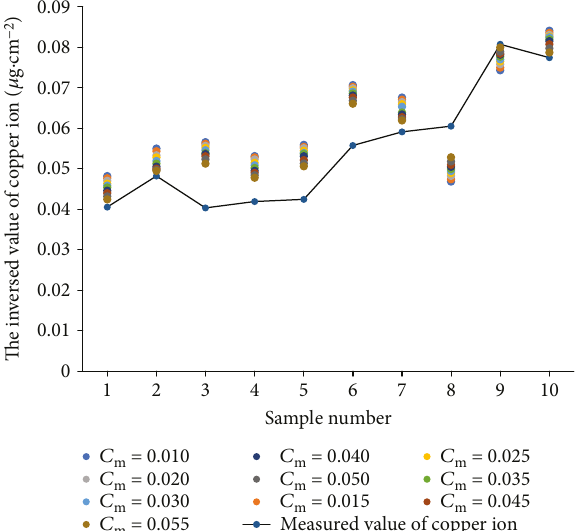
Figure 7: The inversed copper ion contents under di ff erent dry matter contents. The horizontal and vertical axes represent the sample number and copper ion content, respectively.